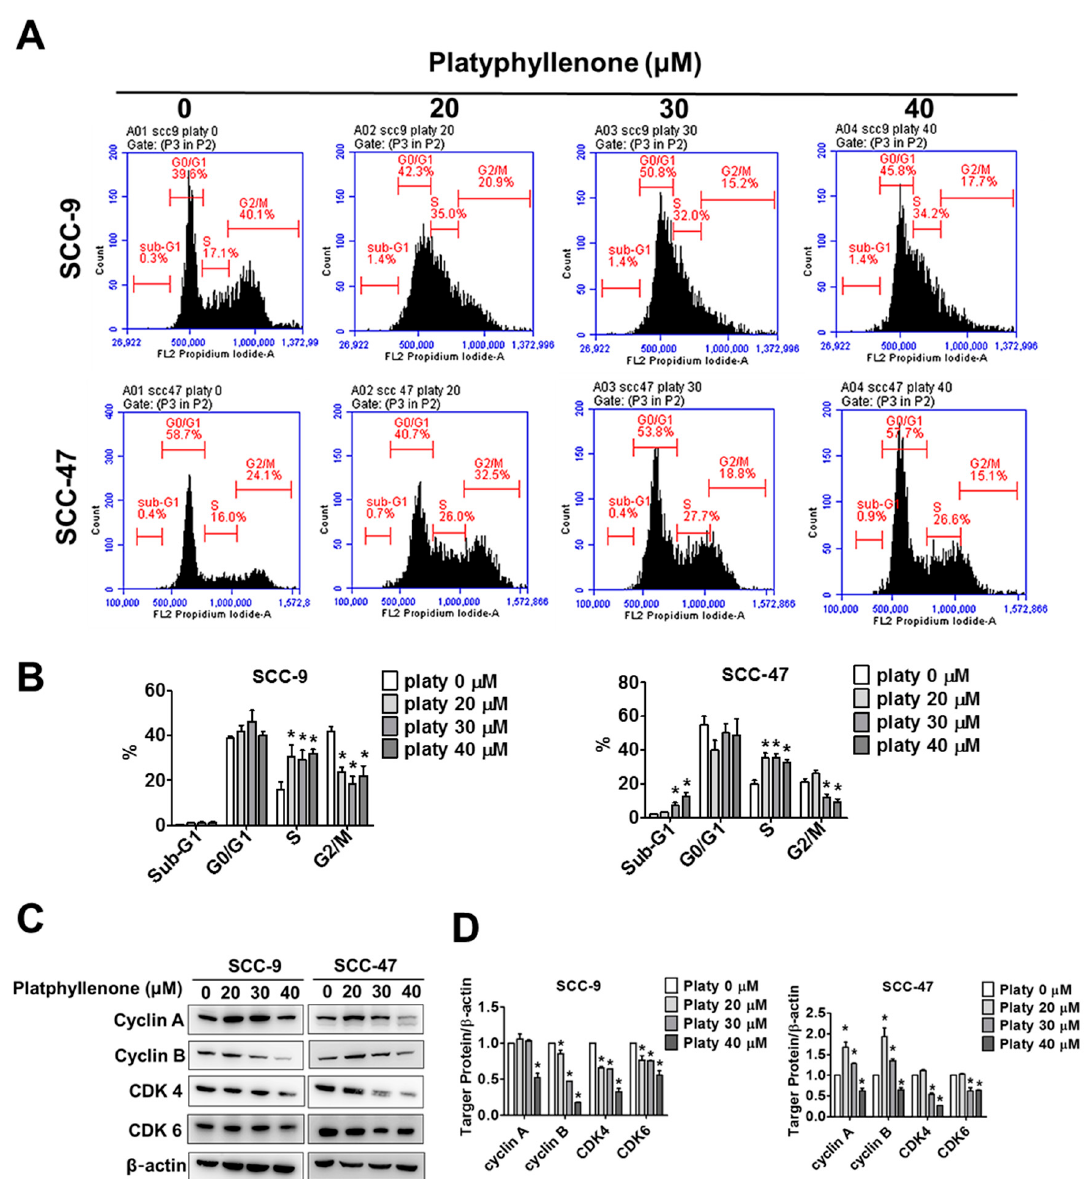
Figure 2. Effect of platyphyllenone on cell cycle progression in oral cancer cells. ( A ) The SCC-9 and SCC-47 cells were assessed by flow cytometry with different concentrations of platyphyllenone (0, 20, 30, and 40 μ M) after 24 h. ( B ) The quantitative analysis of cell cycle at sub-G1, G0/G1, S, G2/M for SCC-9 and SCC-47 cell lines. ( C ) Western blot analysis of effect of platyphyllenone on cell cycle regulatory protein (including cyclin A, cyclin B, CDK 4, CDK 6) expression in SCC-9 and SCC-47 cells. ( D ) Quantitative results of ( C ) in SCC-9 and SCC-47 cells and each protein expression after being adjusted with β -actin. The values represent the means ± SD of at least three independent experiments. Student’s t test was applied to determine statistical significance, and two-tailed p values are shown (* represents p <